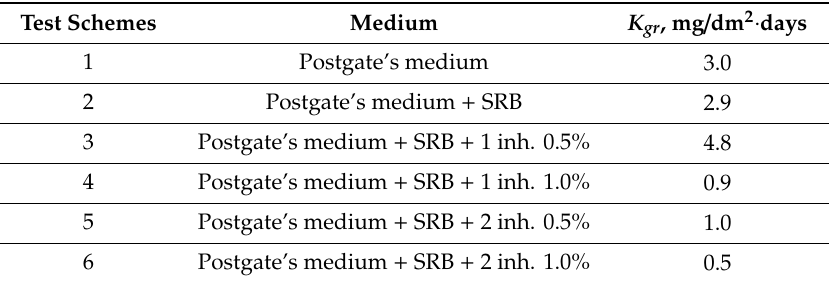
Table 2. Test schemes and biocorrosion rate of specimens from steel 20.